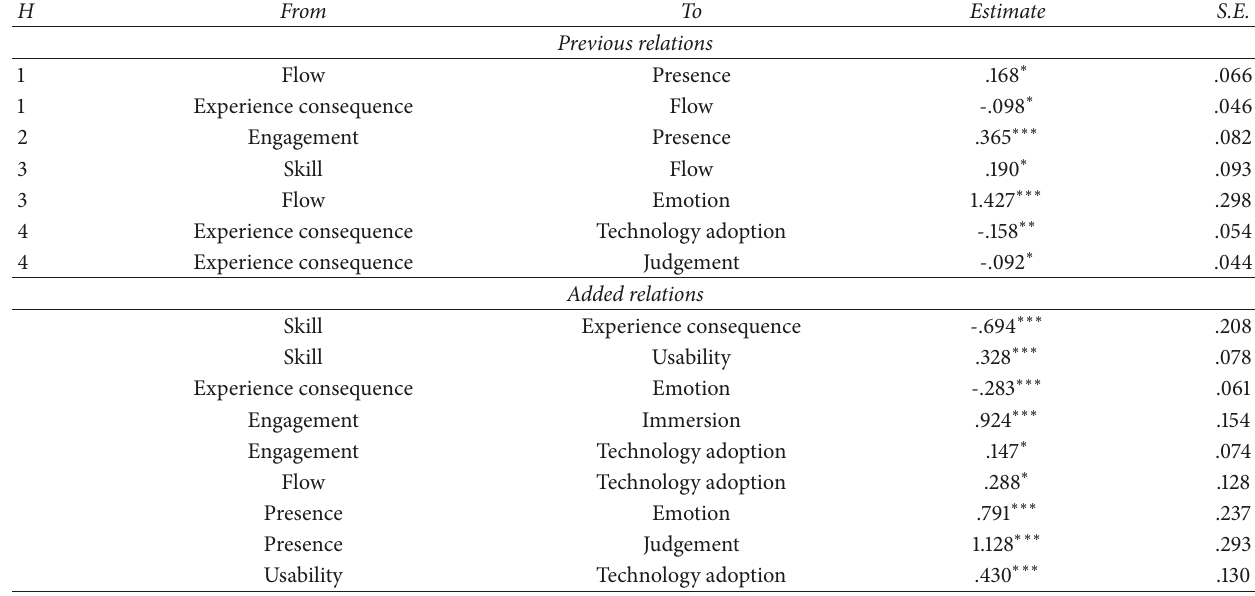
Table 3: Evaluation of the modified UXIVE